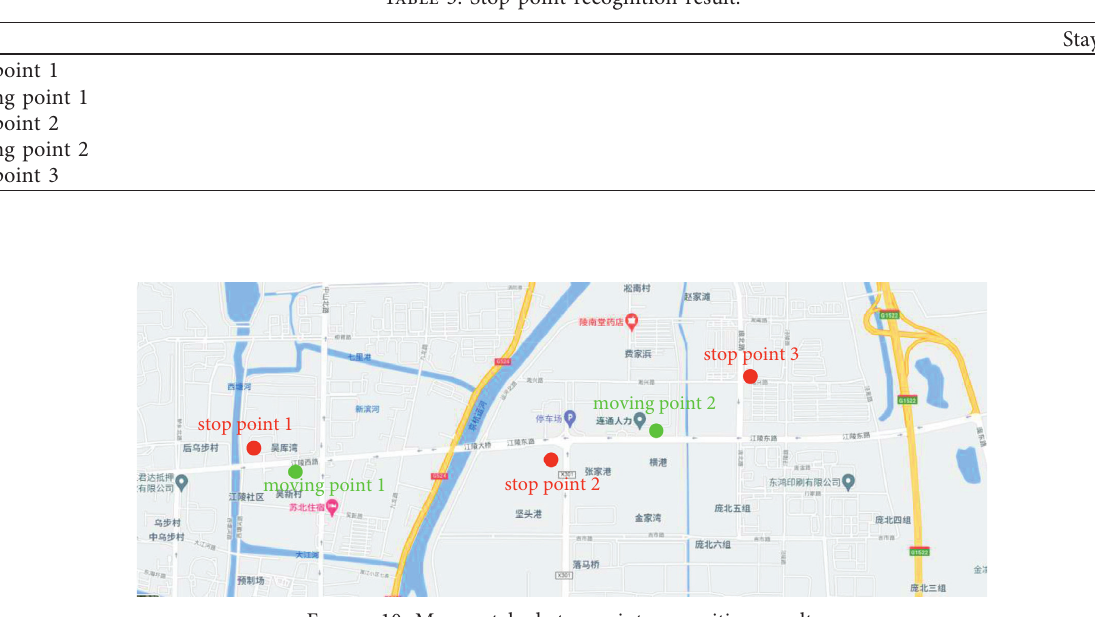
Figure 9: Data point distribution before and after processing. Table 3: Stop point recognition result.